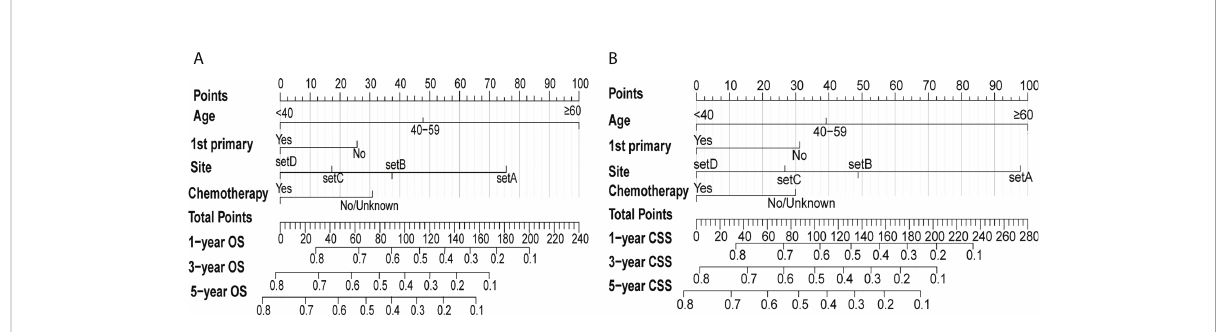
FIGURE 4 Nomograms of predicting the 1-, 3- and 5-year OS rates (A) and CSS rates (B) for eMS patients. The fi rst line called “ Points ” is the score reference of the 4 variables below. For any given patient, the score of each variable can be obtained by drawing a vertical line from the corresponding scale axis to the fi rst line “ Points ” . Then, sum up the 4 scores to obtain the total points, which can be mapped to predict 1-, 3-, and 5-year survival rates by drawing a line descending from the axis labeled “ Total points ” to the 3 survival axes.